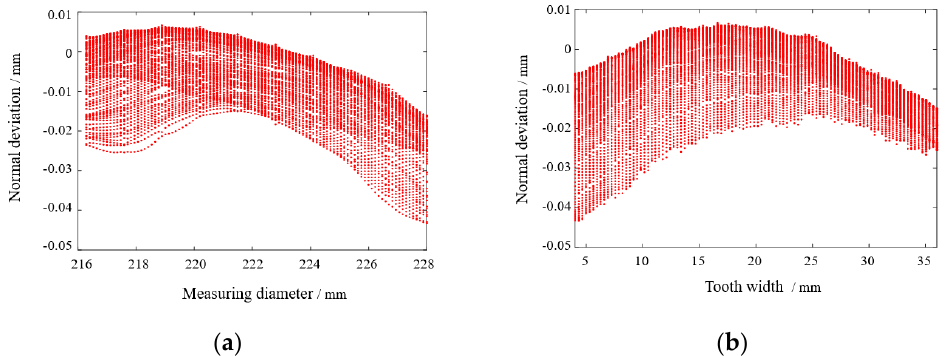
Figure 13. Comprehensive curves of the tooth surface: ( a ) profile deviation; ( b ) helix deviation.